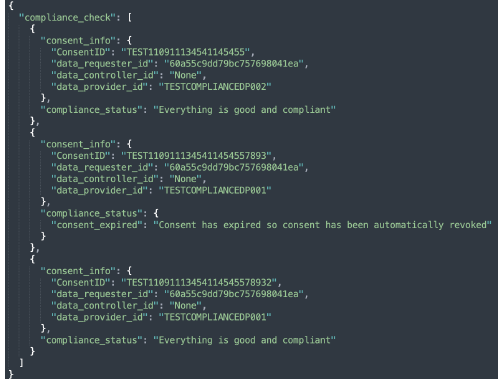
Figure 14. Sample response for an automated compliance check.